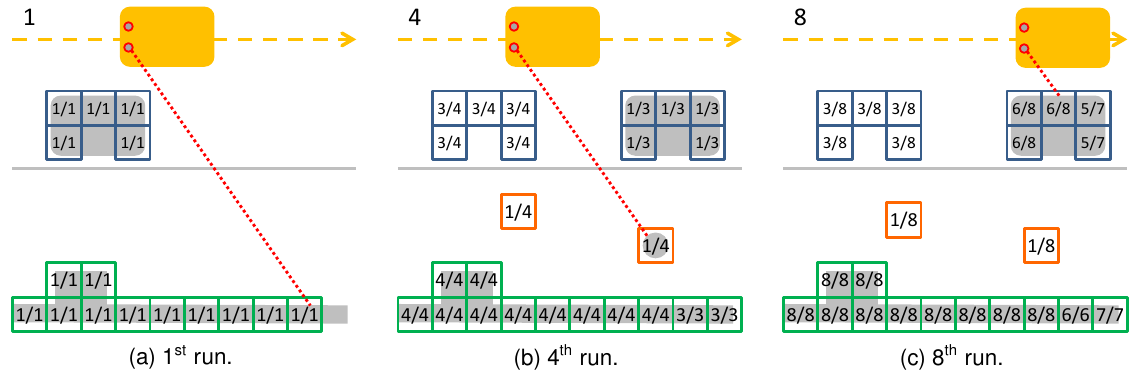
Figure 7. Illustration of voxel counting. On its way along the trajectory, the laser scanner (red) on the vehicle (yellow) permanently scans its environment. If the laser beam is reflected by an object, e.g. a building facade (green), the corresponding voxel count in the occupancy grid increases. The first value in the voxels indicates how often the laser beam hits the voxel, the second value how often the voxel was visible (i.e., the laser beam hits or crosses the voxel). The pedestrians (orange) have only been seen once. The parked cars (blue) on the street have been seen in three or six of eight measurements. Voxels to the right of the red beam are yet to be scanned. pattern, in the previous step. Counting unique patterns results in the “number of patterns” column in table 1.